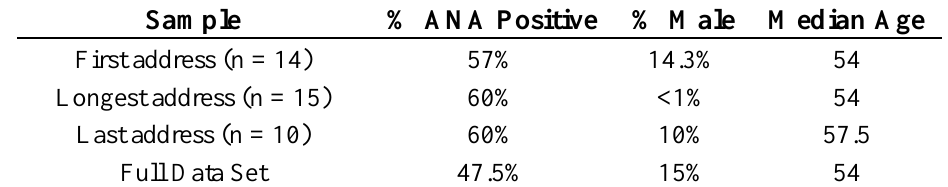
Table 1. Descriptive statistics associated with the validation study sample compared to the full data